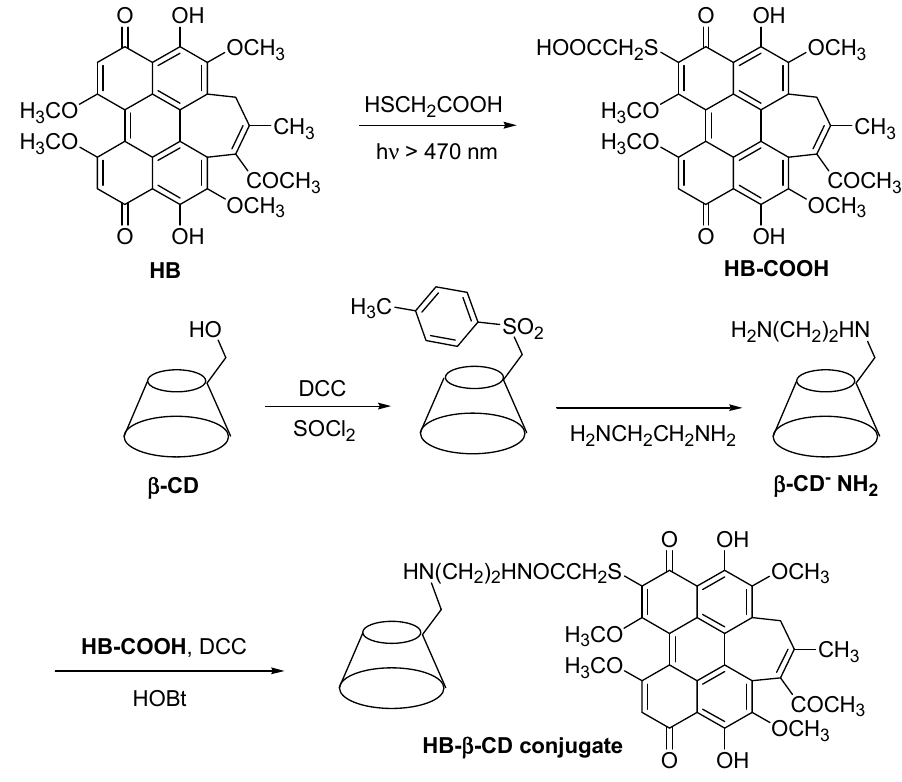
Figure 33. Synthesis of HB- β -CD conjugate.